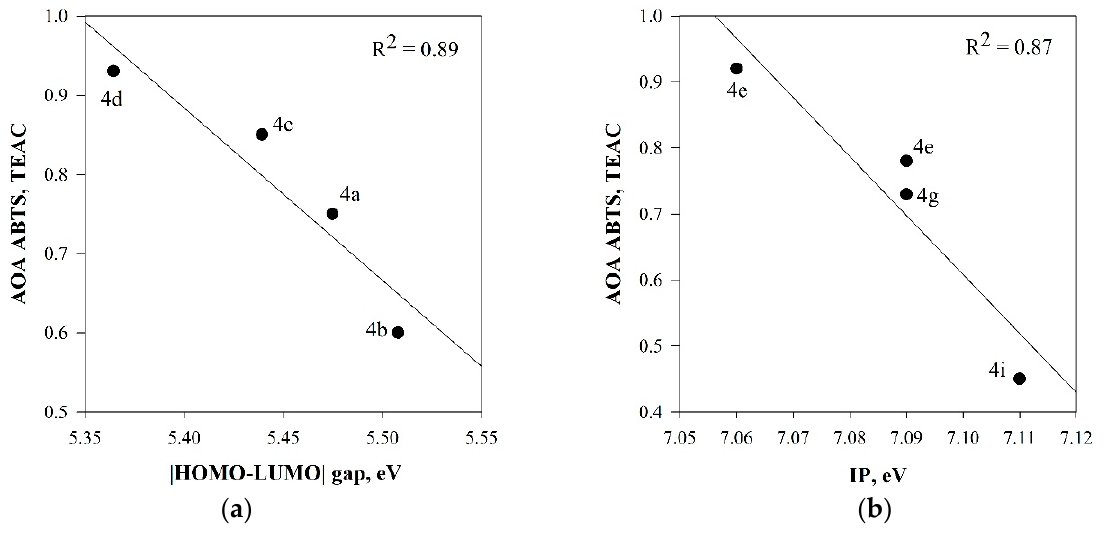
Figure 2. Antioxidant activity ( АОА , ABTS) vs. gap functions for 4-aminopyrazolols 4a–d ( a ) and ( АОА , ABTS) vs. IP functions for 4-aminopyrazolols 4e , 4h–i ( b ).